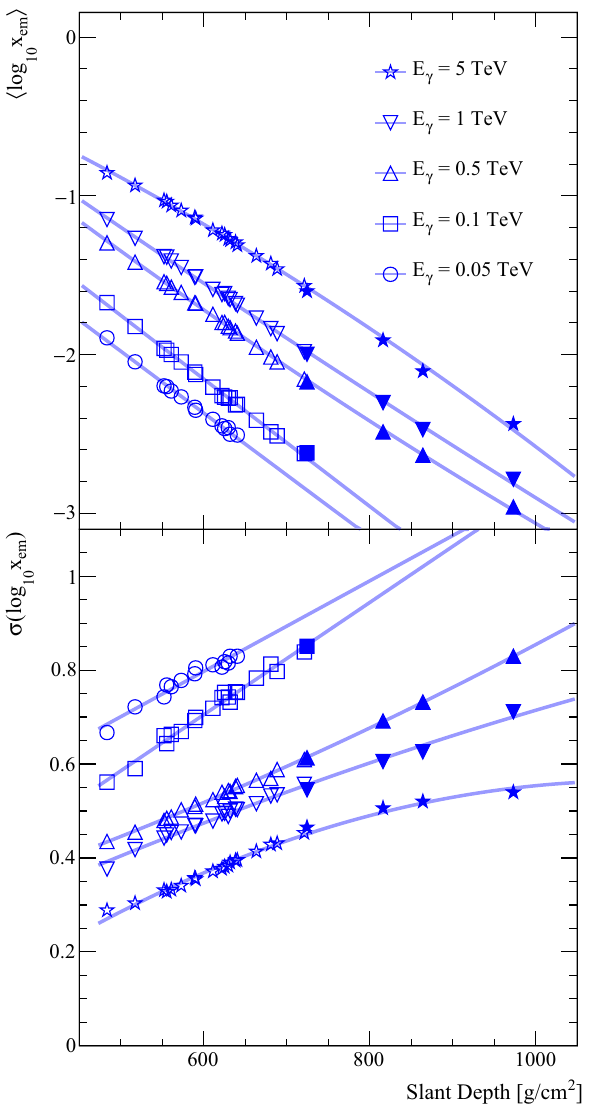
Fig. 6 Dependence of fractional electromagnetic energy arriving at ground x em = E em / E p on slant depth, for primary protons of differ- ent energies. The top panel shows the dependence of the mean of the log 10 ( x em ) distribution, while the bottom panel shows the behaviour of the rms ( σ ) of the same distribution. Each data point corresponds to the slant depth of a combination of zenith angle and ground-level from Fig. 14, filled markers correspond to simulation sets that have a zenith angle larger than 30 ◦ . Error bars are of similar size as the markers or smaller